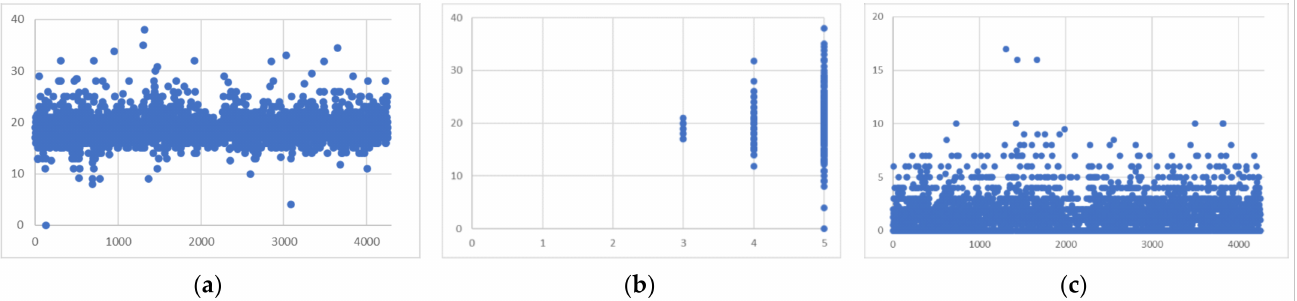
Figure 2. Sentiment analysis results: ( a ) Distribution of sentiment scores; ( b ) rating stars × emotional scores; ( c ) distribution of emotional polarity.